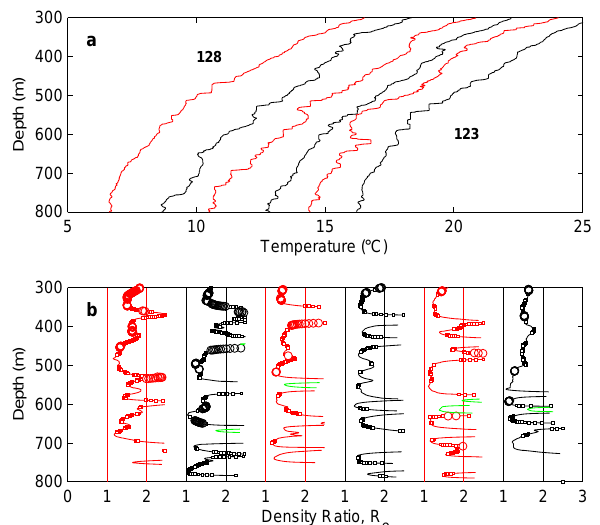
Fig. 4. Profiles of a) temperature and b) density ratio, R ρ inferred from the HRP dives deployed in 2001. Dive 123 indicates data upon a synthetic seismic study was based. The temperature scale is correct for the leftmost CTD. Each subsequent profile is offset by 2 ◦ C, shown in alternating red and black color. Density ratio pro- files are offset and colored accordingly with R ρ = 1 and 2 indicated by vertical lines. R ρ > 2 . 5 are masked for clarity. The portions favoring diffusive-layer convection 0 < R ρ < 1 are highlighted us- ing 1 /R ρ (green, shown in the range 1 < 1 /R ρ < 2 . 5). The size of the circles are scaled according to the magnitude of 10-m shear ( < 1 × 10 − 3 s − 1 , no marker; (1–3) × 10 − 3 s − 1 ; (3–6) × 10 − 3 s − 1 ; and > 6 × 10 − 3 s − 1 , large marker) .